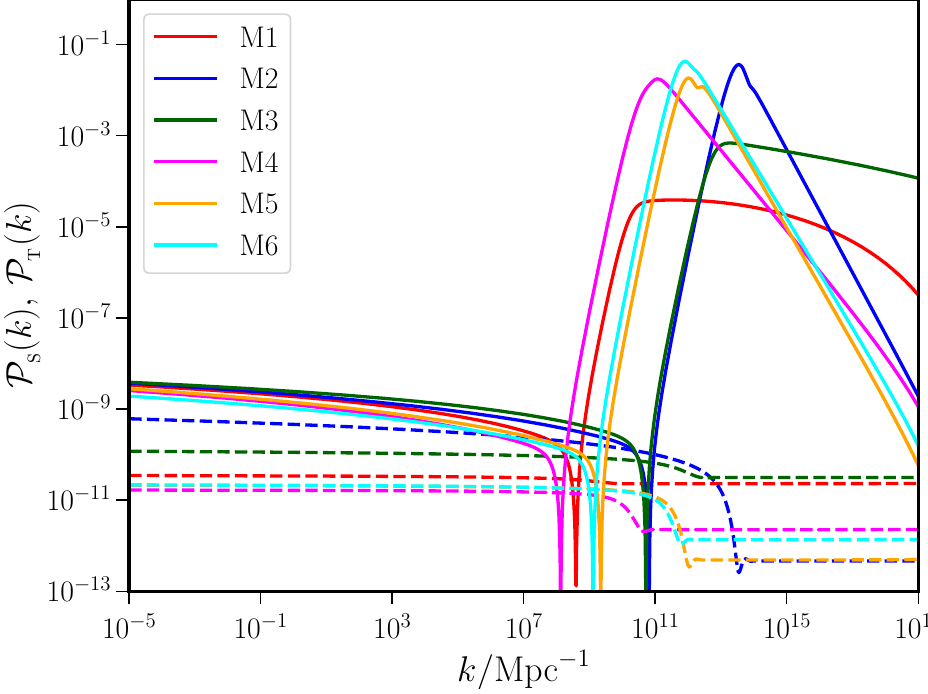
( k ) (in solid lines) and the tensor power spectrum ( k ) (in P S P T and tensor-to-scalar ratio r , evaluated at the pivot scale of S for the ∗ and r mentioned below. Note that, apart S and r that are fairly inconsistent with the CMB data. S